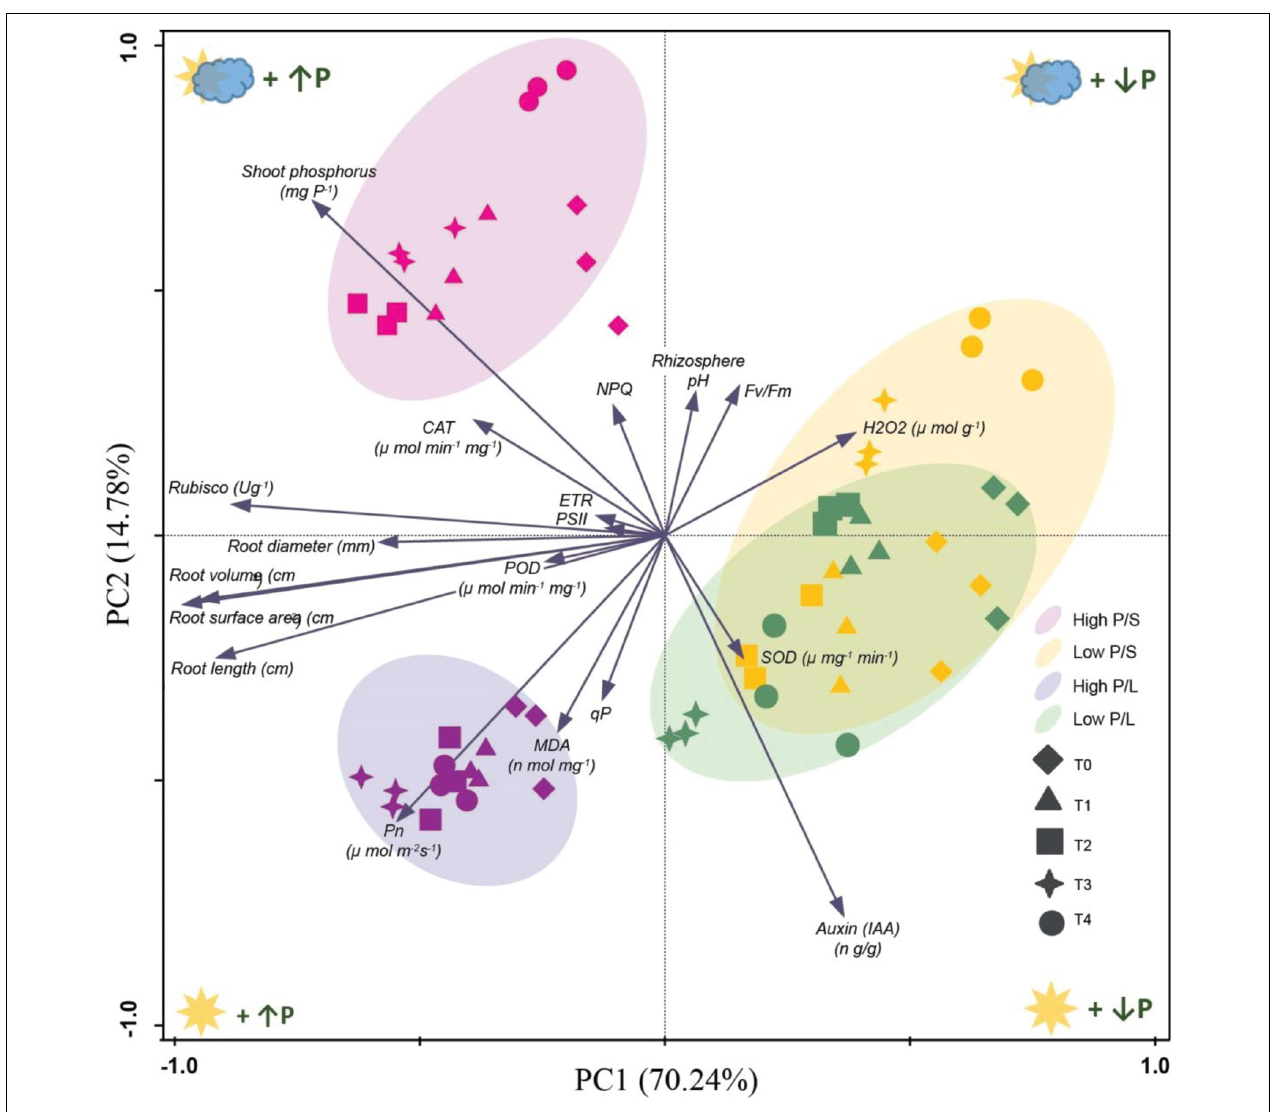
FIGURE 14 | Principal component analysis (PCA) representing reaction of application of titanium on soybeans under normal light (NL) and shade conditions (SC) combined with low and high phosphorus (LP and HP) stress respectively. The first two axes (show in the diagram) explain 85% of the total